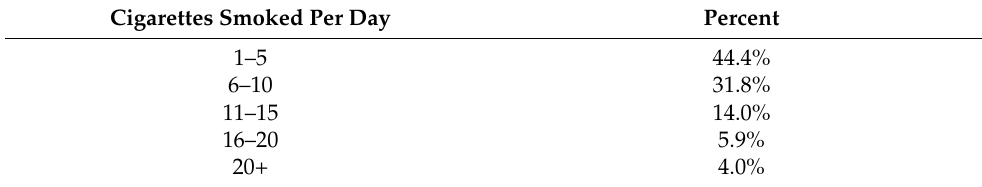
Table 2. Number of cigarettes smoked by participants per day ( n =